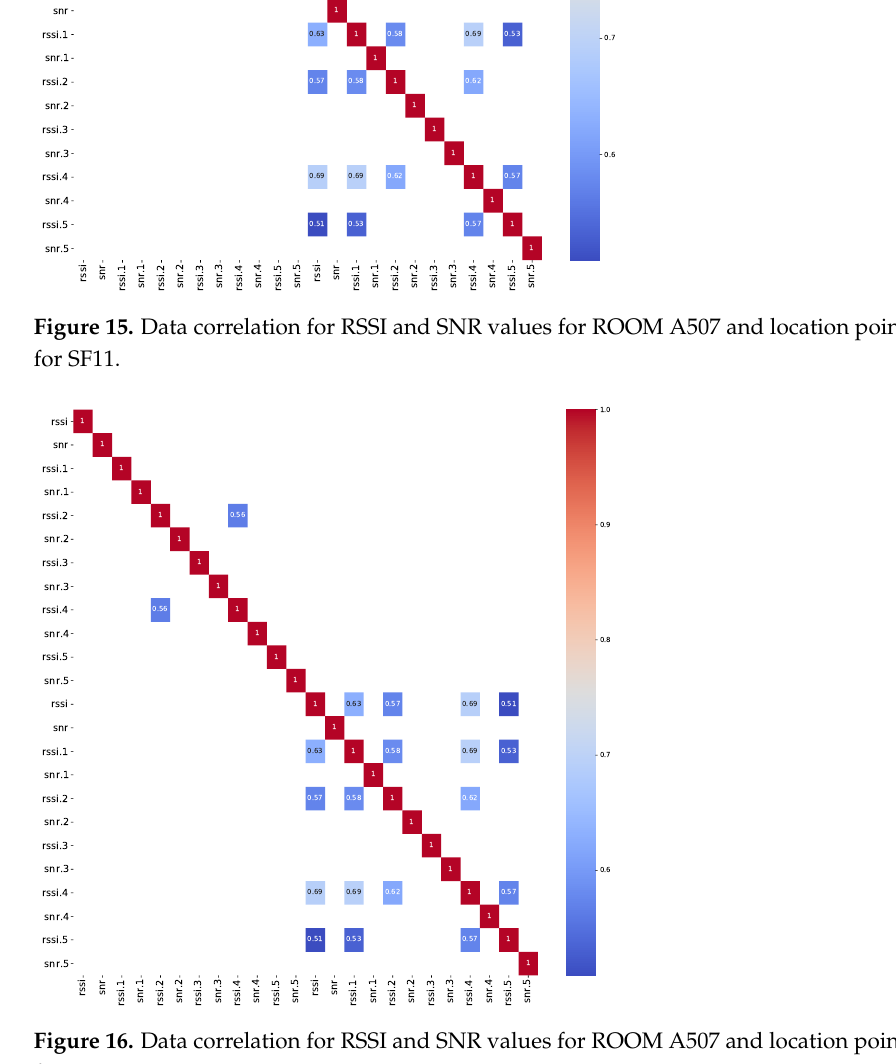
Figure 16. Data correlation for RSSI and SNR values for ROOM A507 and location points 11 and 12 for SF